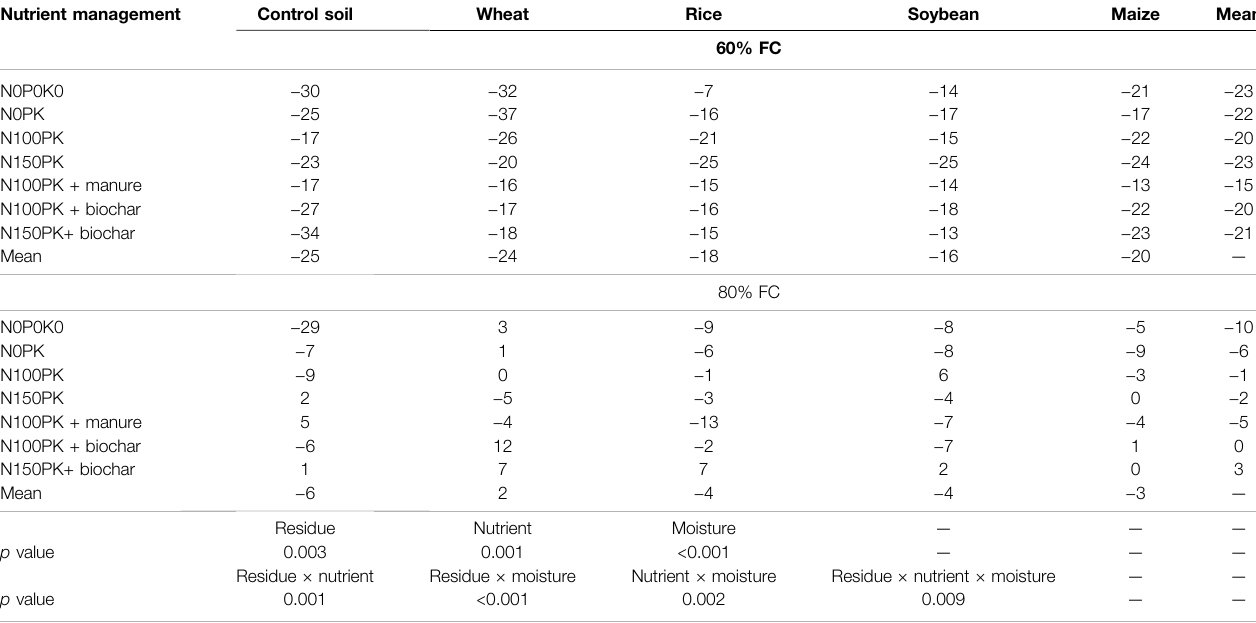
Negative sign indicates a decrease in fl ux from 57 days of